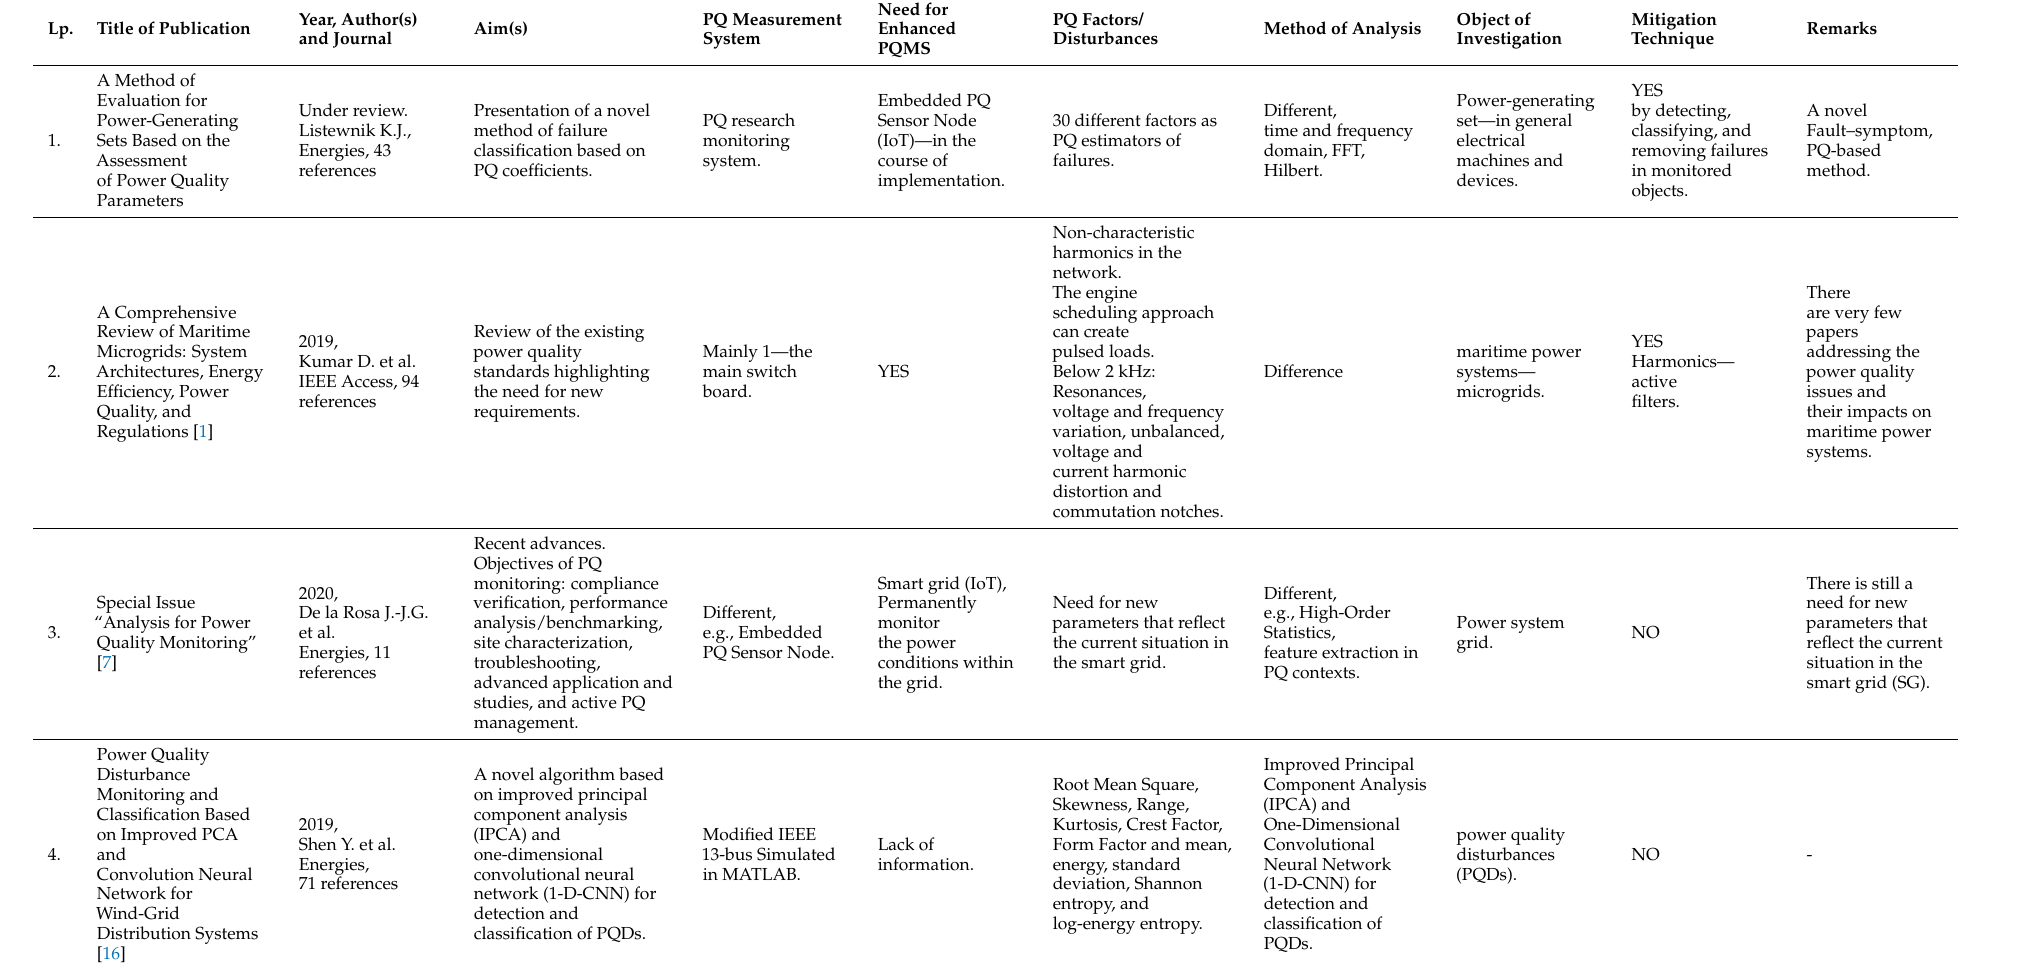
Table 1. Comparison of the scope of current publications concerning the use of PQ